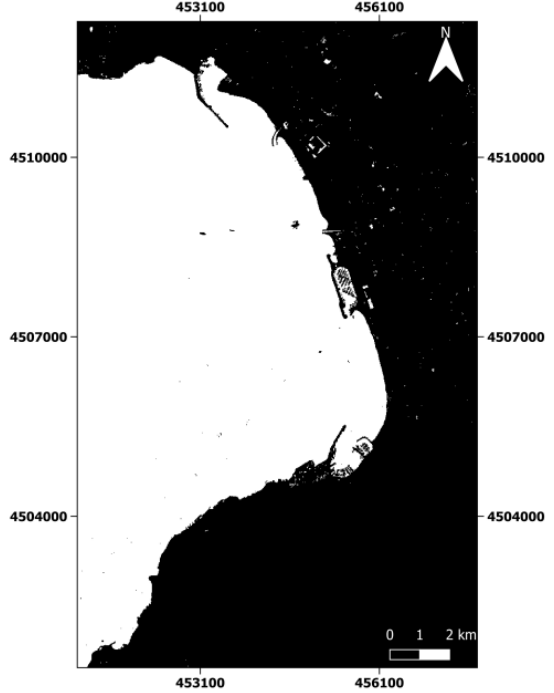
Figure 4. Result of K-Means clustering applied to NDWI: land is represented in black, while water is represented in